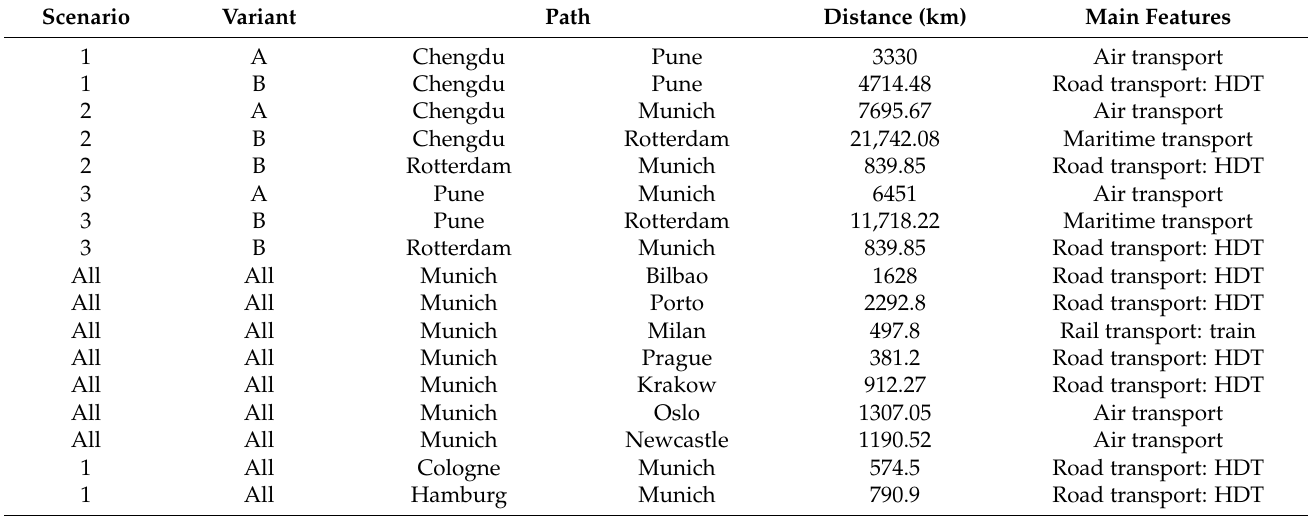
Table 6. Different geographical points that compose the logistic network involved in this product’s production. Scenario